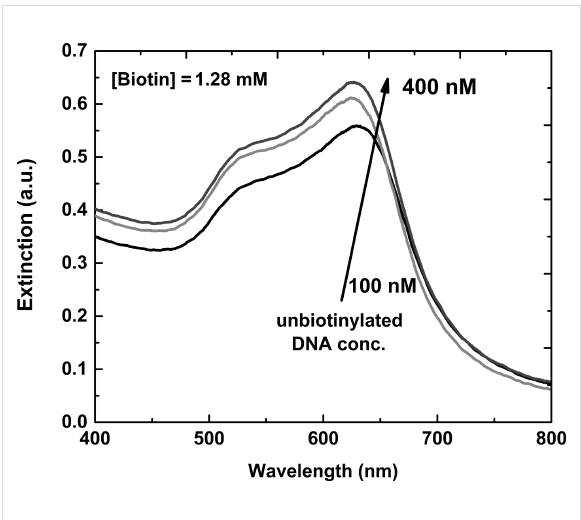
Figure 9: Extinction spectra (400–800 nm) of AuNP-SA in the pres- ence of free biotin (1.28 mM) titrated with unbiotinylated DNA (solu- tions: 100 nM, 200 nM and 400 nM,